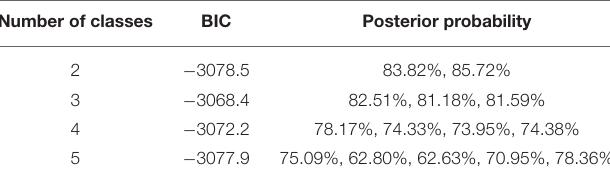
TABLE 2 | Fit statistics for group-based censored normal model with 2–5